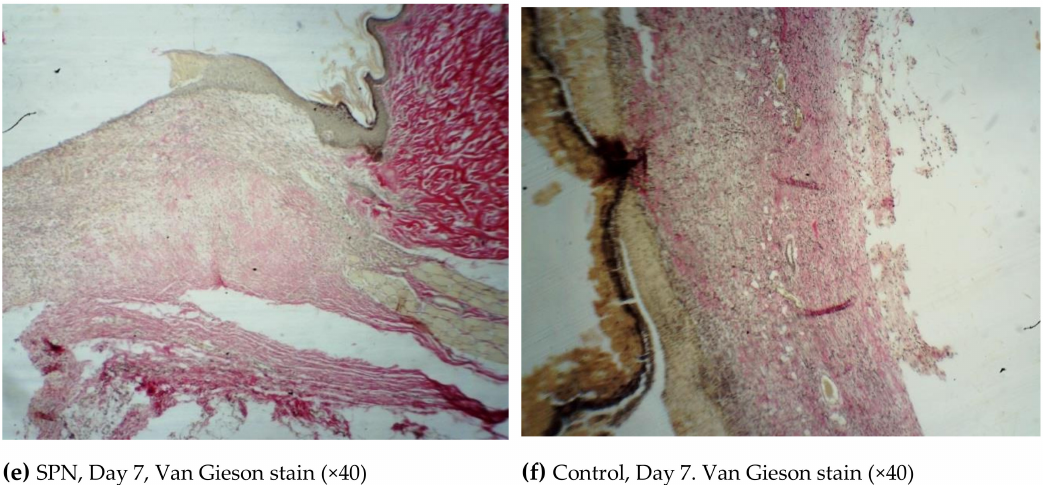
Figure 4. Morphological patterns of the SPN group wounds ( a , c , e ) and the control group wounds ( b , d , f ) on Day 7 of the